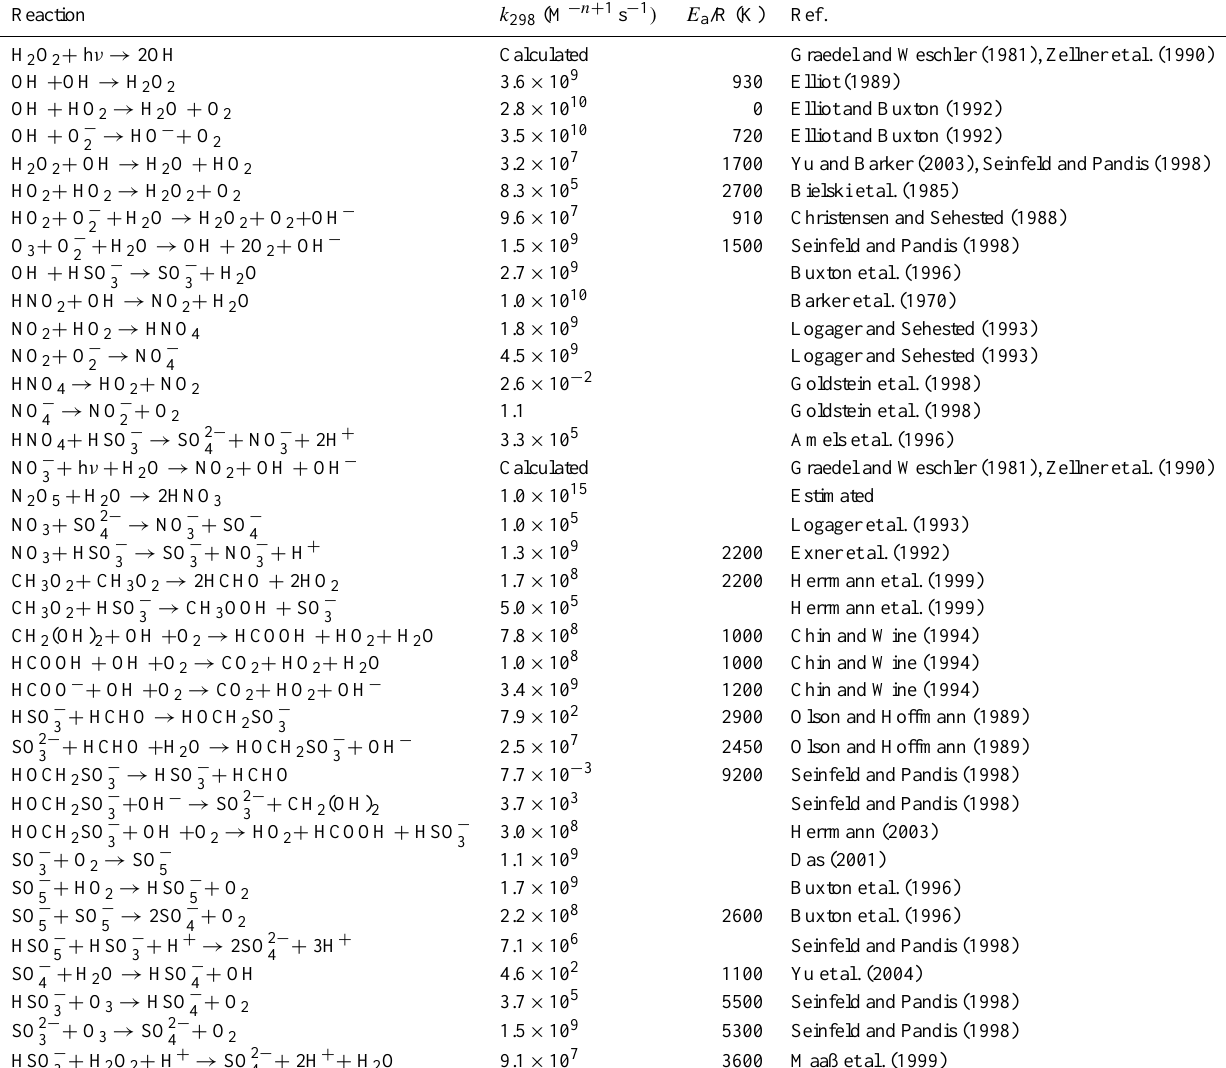
Table 3. Aqueous phase chemical mechanism.